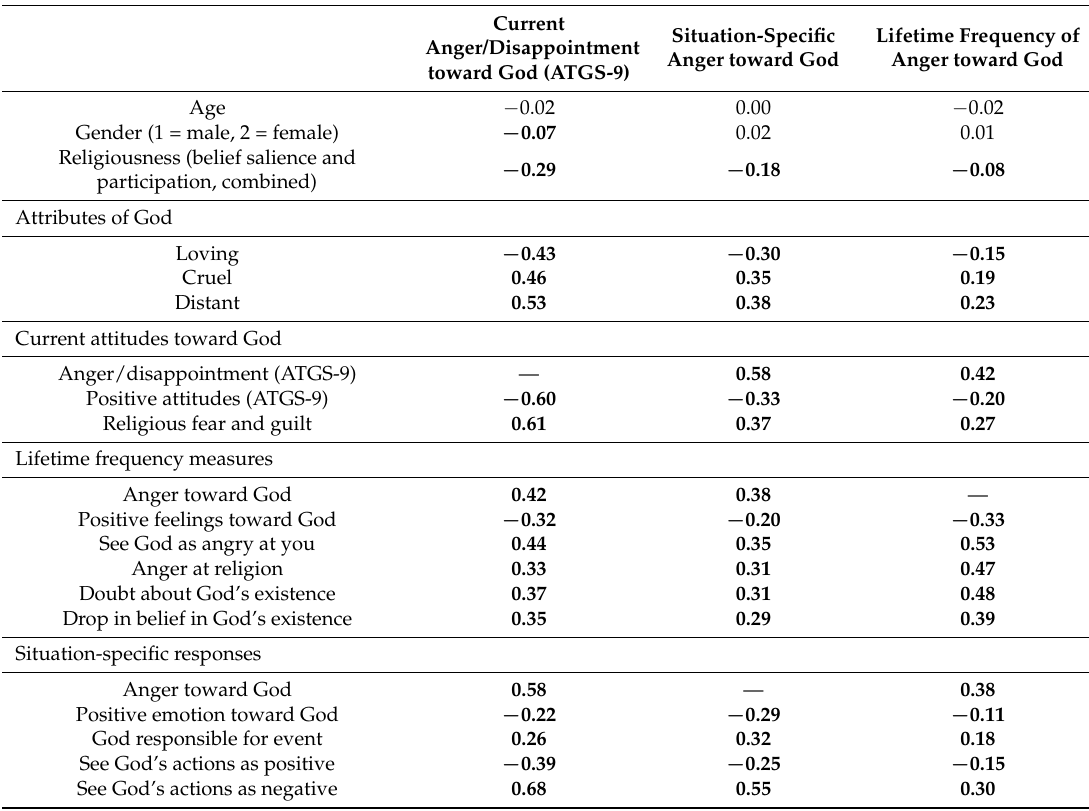
Table 3. Pacific Coastal Christian university sample: Correlations between key study variables and three measures of anger toward